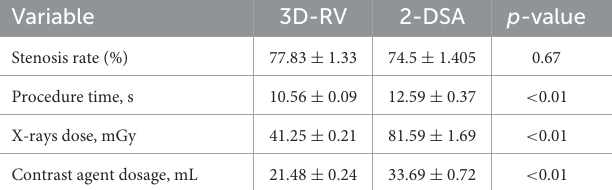
TABLE 3 Comparison of key parameters during the procedure.